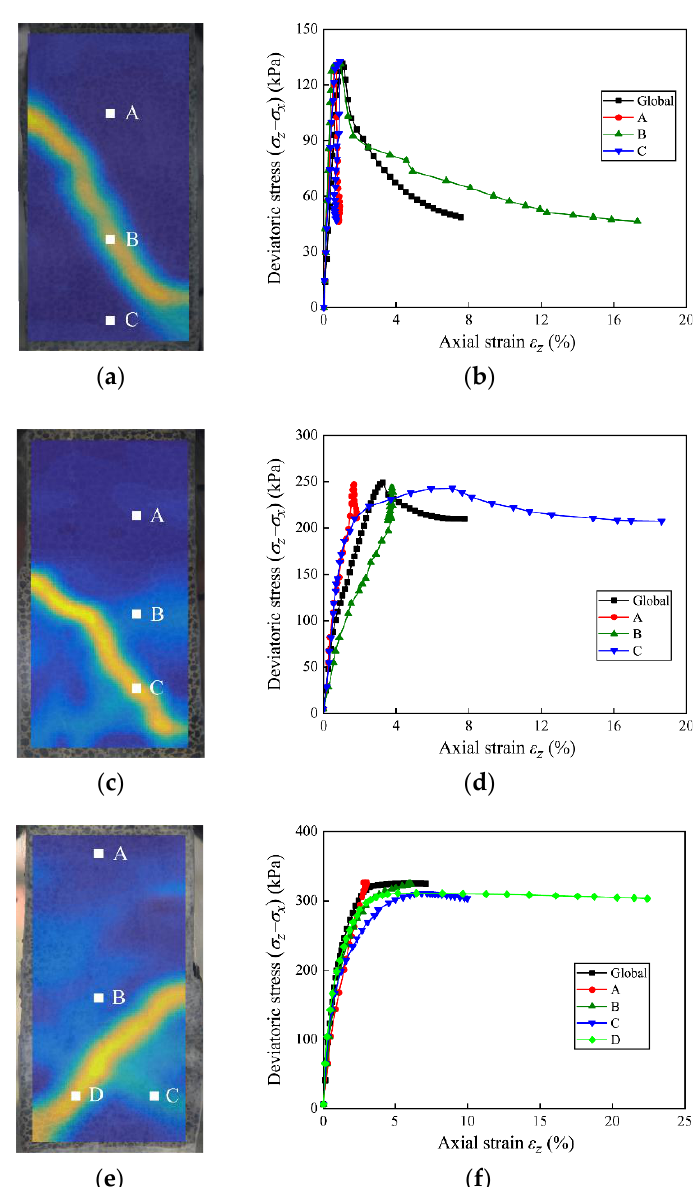
Figure 10. Global and local stress – strain relationships: ( a , c , e ) locations of typical regions in T1, T3, and T5 specimens; ( b , d , f ) global stress – strain curves of T1, T3, and T5 specimens and local stress – strain curves of typical regions in T1, T3, and T5 specimen.